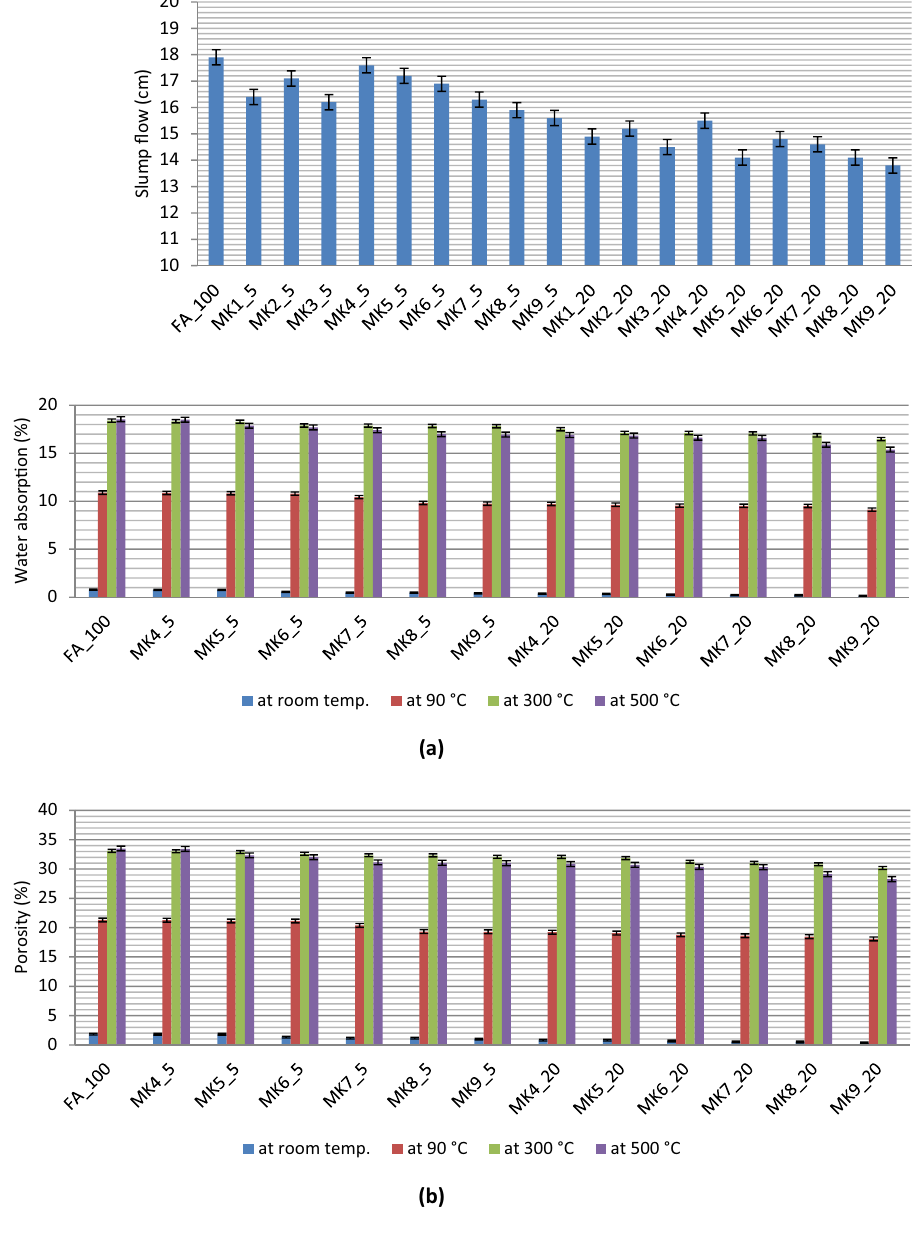
Fig. 3 Results of slump flow for all geopolymer paste investi- gated